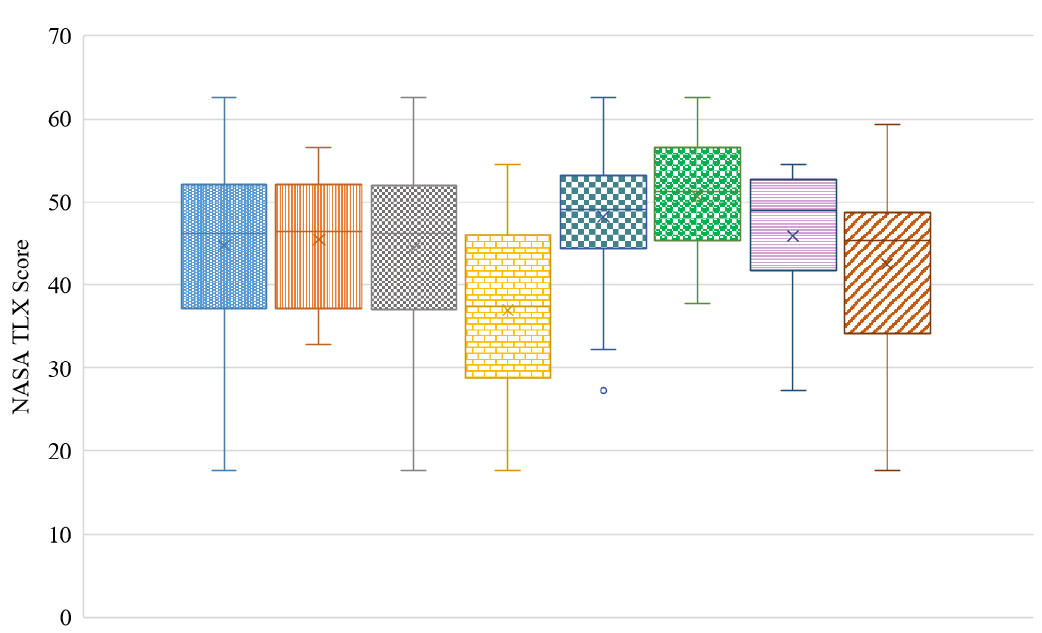
Figure 8. The NASA task load index (NASA-TLX) parameter ranking.